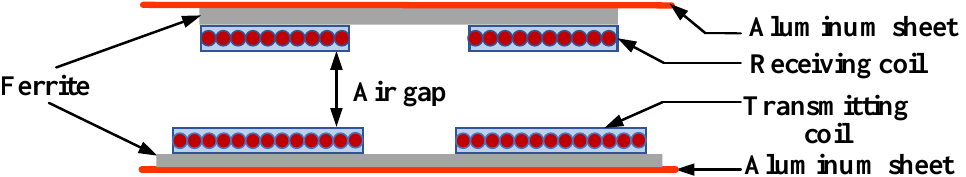
Figure 2. Cross-section view of single shield magnetic coupler.